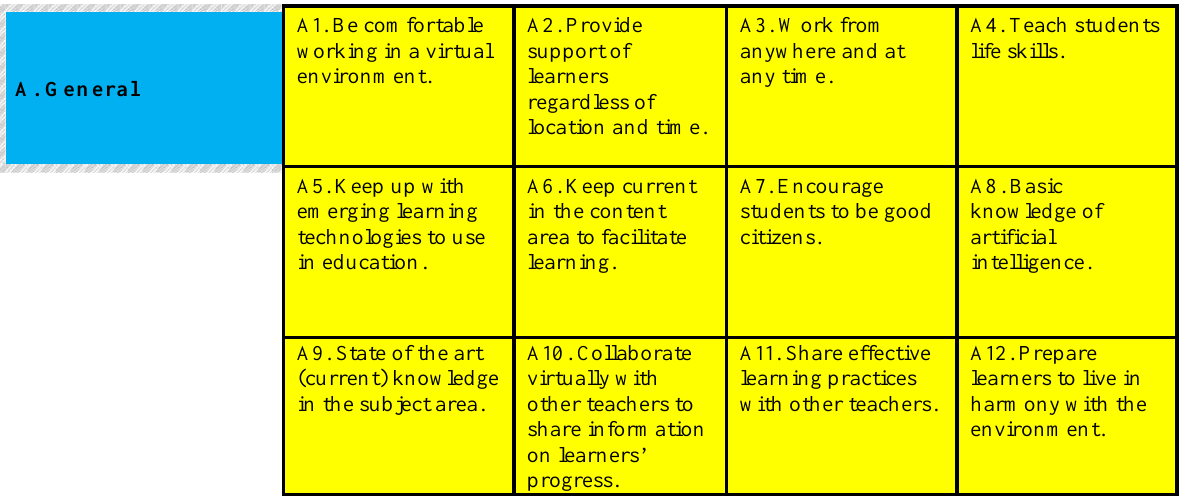
Figure 3. Digital teacher general